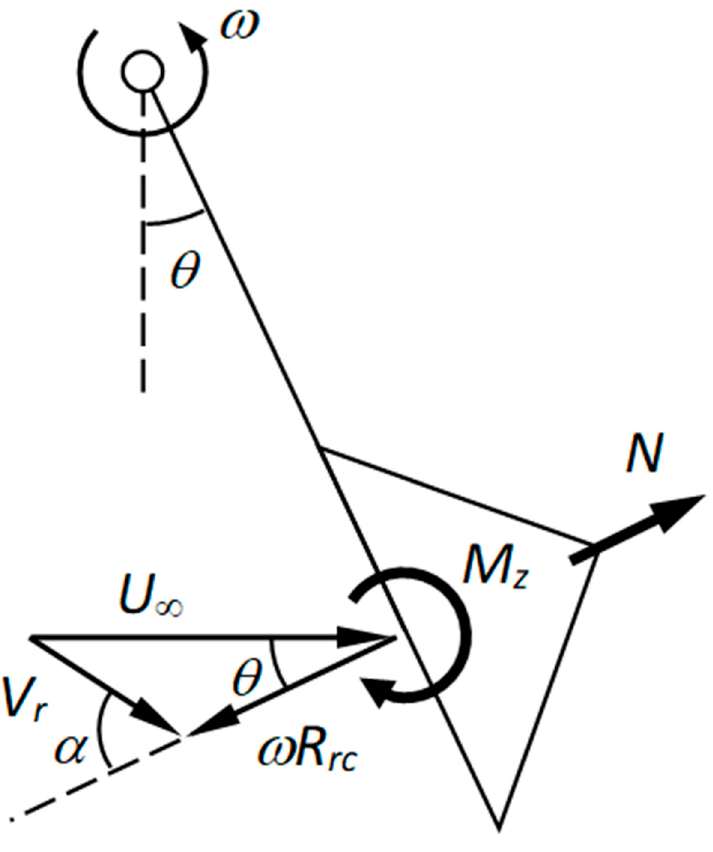
Figure 4. Sketch that shows the wind speed, U ∞ , the relative-to-the-cup wind speed, V r , and the two angles involved: the one, α , that indicates the wind speed direction in relation to the rotating cup and the other one, θ , which indicates the angular position of the cup (i.e., the angular position of the rotor).